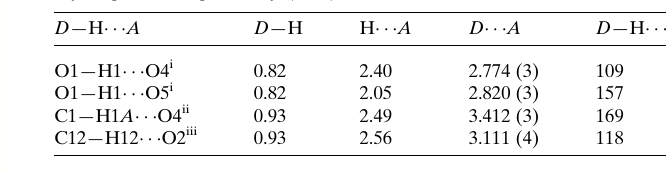
Table 1 Hydrogen-bond geometry (A˚ , (cid:2)